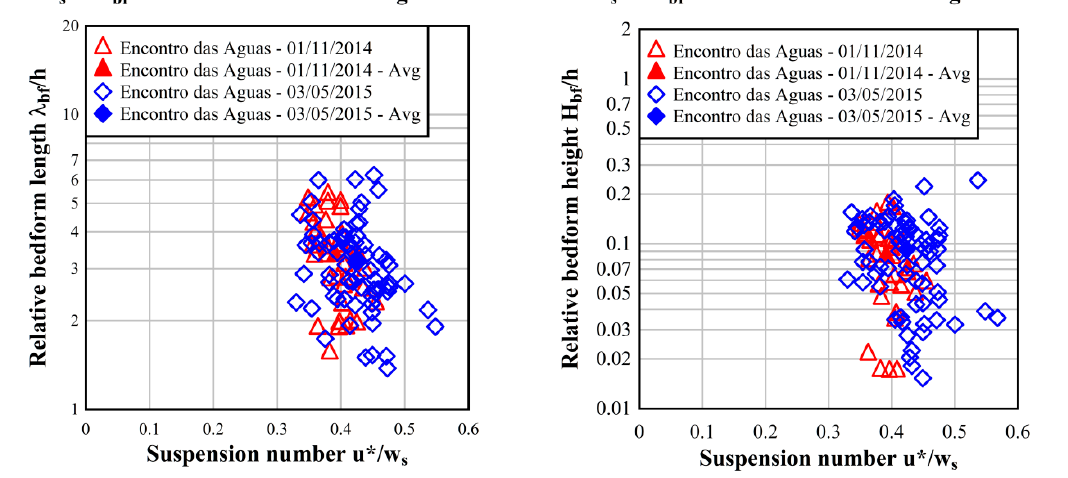
Figure 16. Suspension number u*/w s vs. λ bf /h (left) and vs. H bf /h (right).